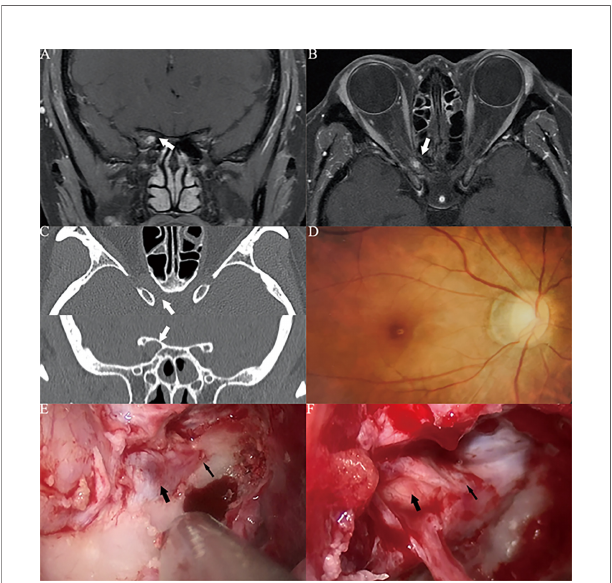
FIGURE 4 | Case2. A 32-year-old female presented with her right eye vision loss for 8 months and sudden loss of right eye vision for 2 weeks. She was misdiagnosed as optic atrophy in the local hospital and was given hormone therapy. (A, B) Optic nerve MRI showed that the right optic nerve sheath occupies, uniformly enhanced, the tumor diameter is less than 1cm (white thick arrow). (C) CT of the optic canal shows that the right optic canal is wider than the left (white thick arrow). (D) Fundus photography shows atrophy of the right optic disc. (E) The right optic canal (black thin arrow) can be seen under the vision of nasal endoscopic surgery, and the space occupying under the optic nerve sheath near the orbital foramen is blue stained. (F) After resection of cavernous hemangioma, the right optic nerve was well protected (black thick arrow), and the cranial foramen of optic canal was behind it (black thin